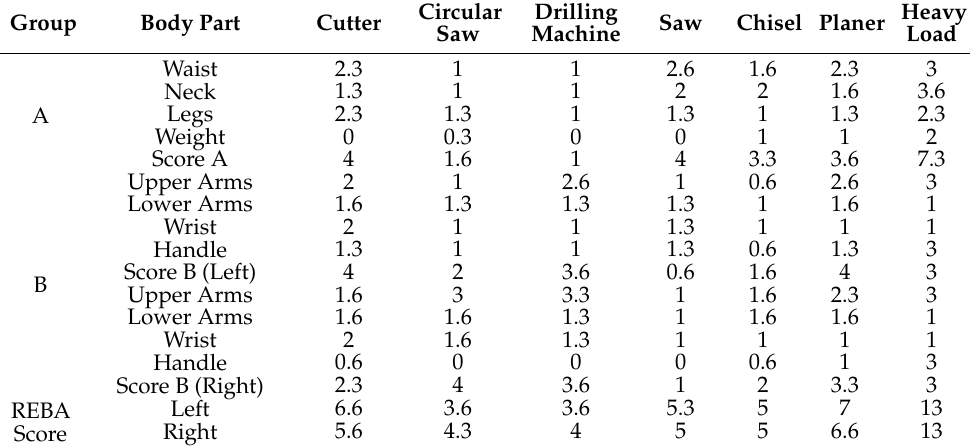
Table 18. REBA evaluation results by experts (average).